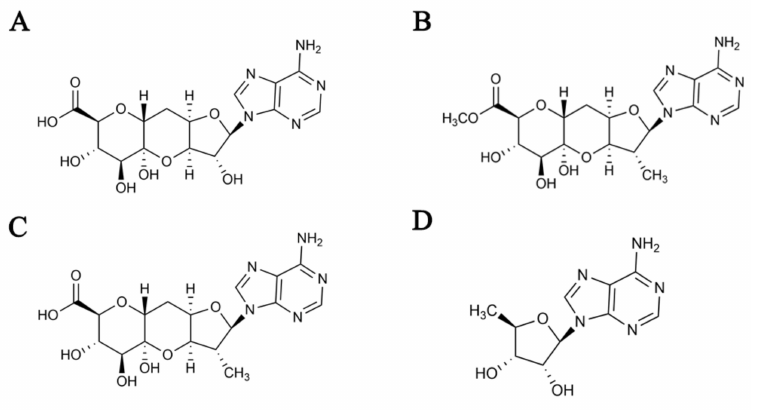
Figure 1. The structure of anreonucleomycin and hepcidin. ( A ) Aureonuclemycin A; ( B ) Aureonu- clemycin B; ( C ) Herbicidin C; ( D ) Herbicidin D.